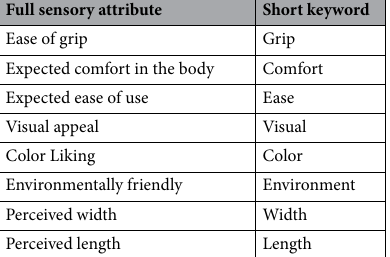
Table 1. Measured sensory attributes and keywords used to refer to them in figures and